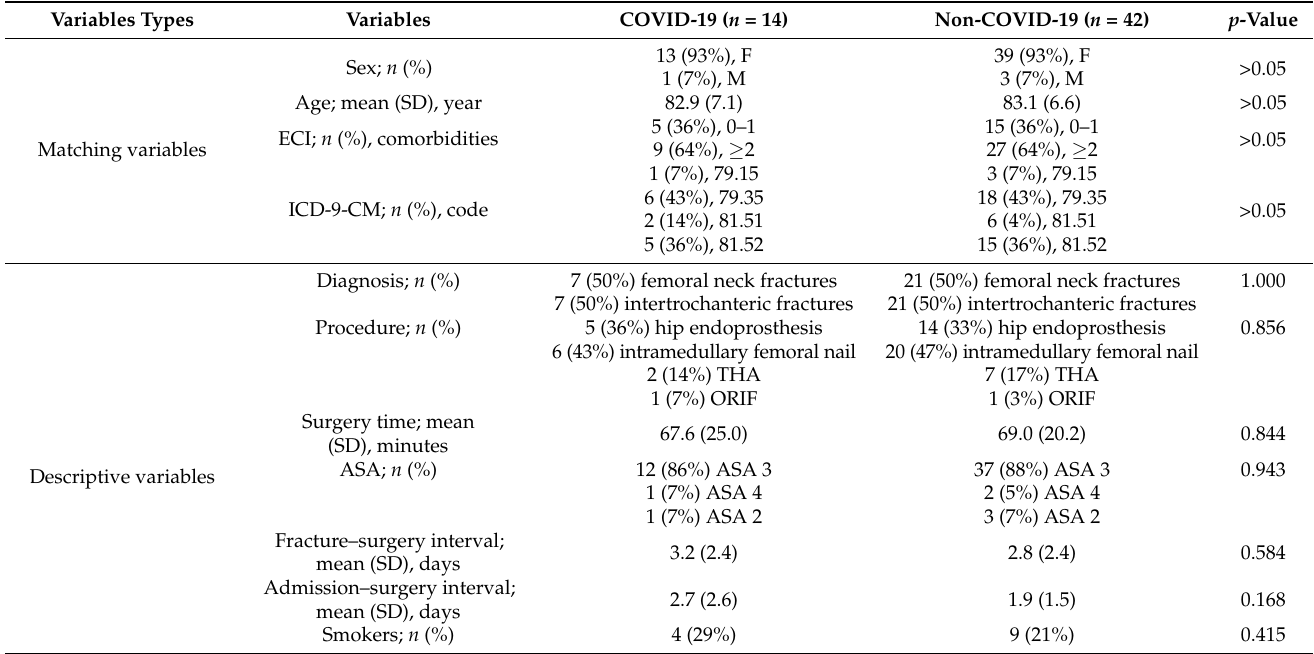
Table 1. Characteristics of cases and